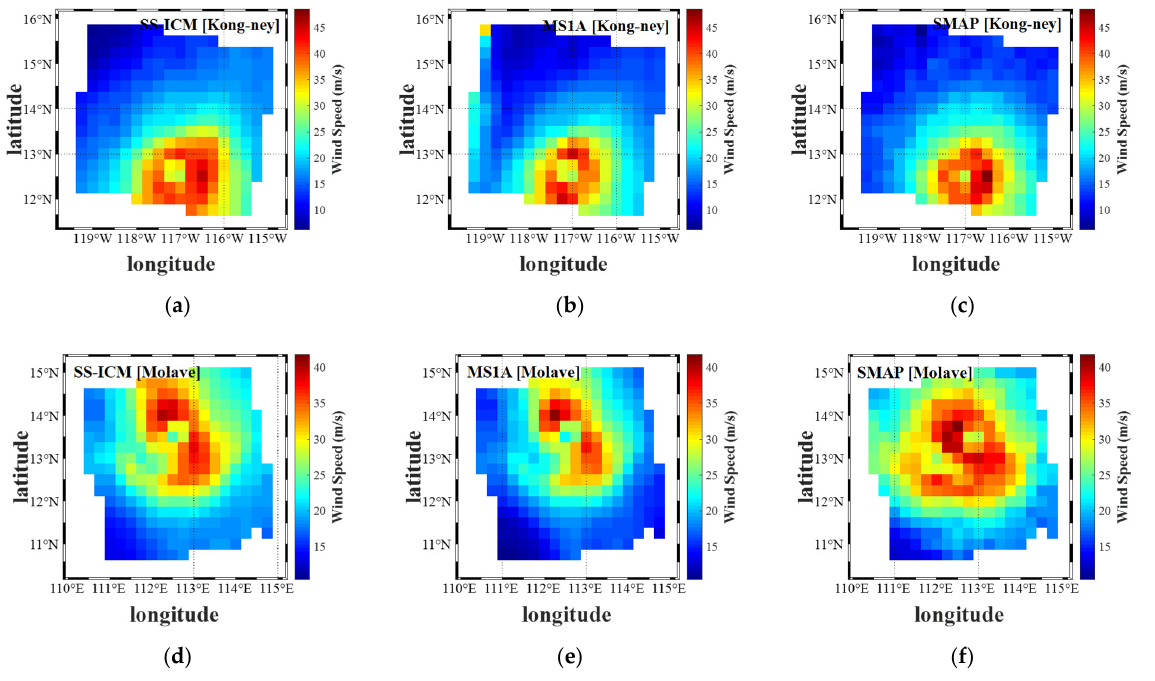
Figure 18. Wind speed retrieved by SS-ICM, MS1A model, and the wind speed from SMAP ( a – c ) corresponding to TC Kongney and ( d – f ) TC